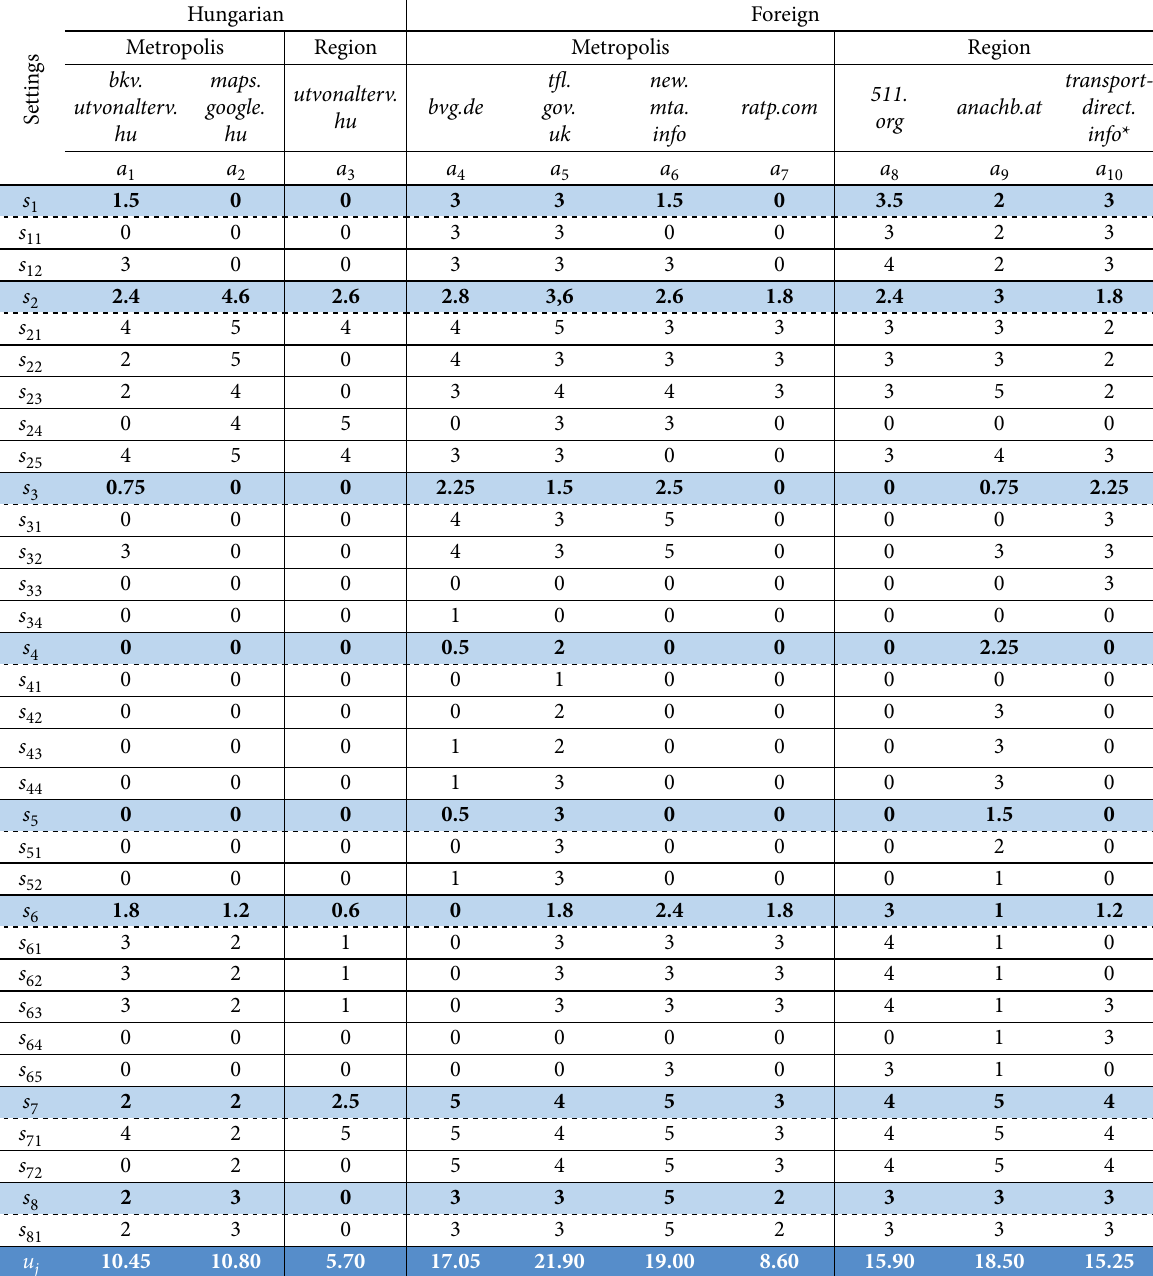
Table 5. Application of the developed method – results based on data of 2014 autumn (source: research by the